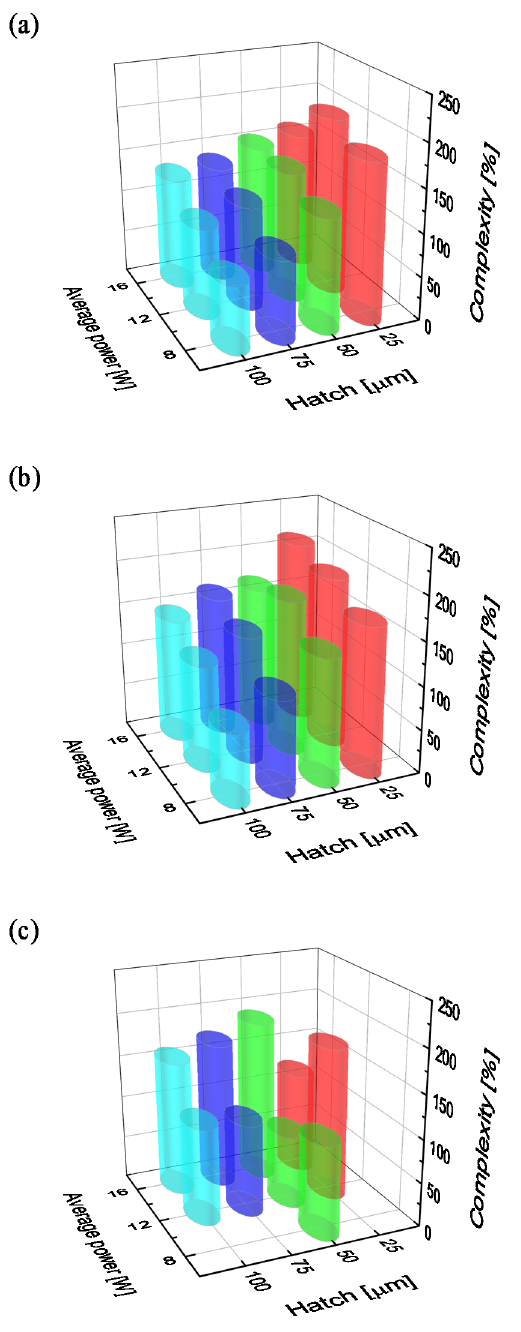
Figure 3. The surface complexity of the Ti6Al4V alloy as a function of the average laser power and hatch distance at the selected scanning speed during laser processing in pulse mode: 1800 mm/s ( a ) and 1200 mm/s ( b ), and at a continuous wave with a scanning speed of 75 mm/s ( c ).